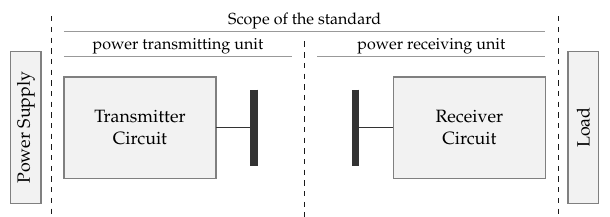
Figure 30. Scope of the ARIB STD-T113 standard